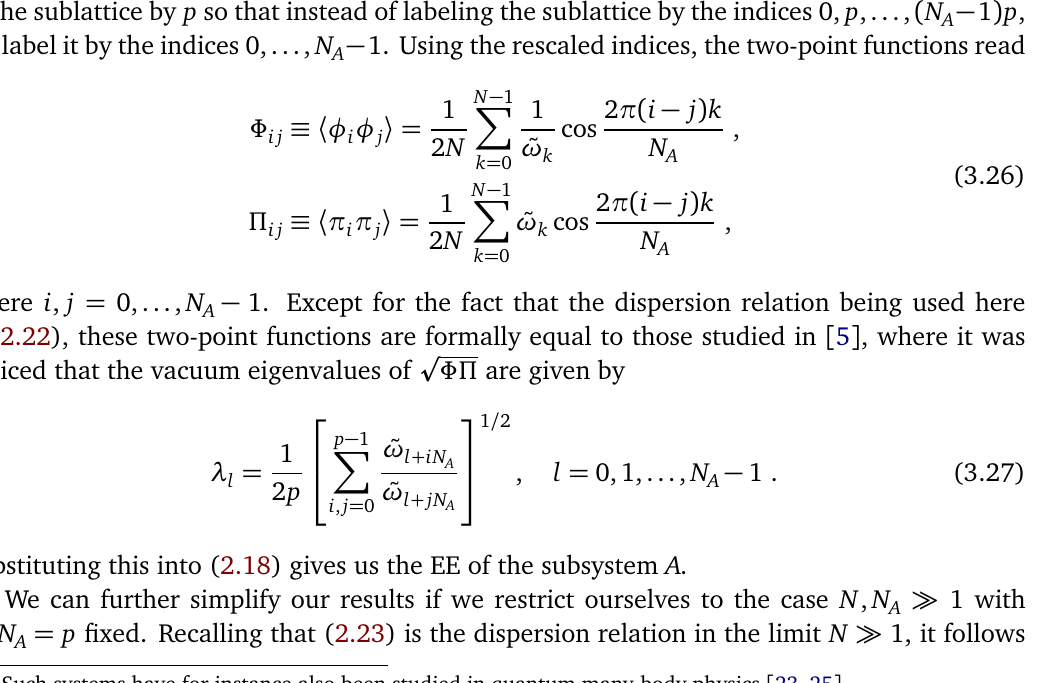
Figure 4: One-dimensional periodic sublattices consisting of N = 12 lattice sites, with subsystem A consisting of the N filled lattice points such that N = pN A = 4 and p = 3. Figure taken from [ 5 ] right N A